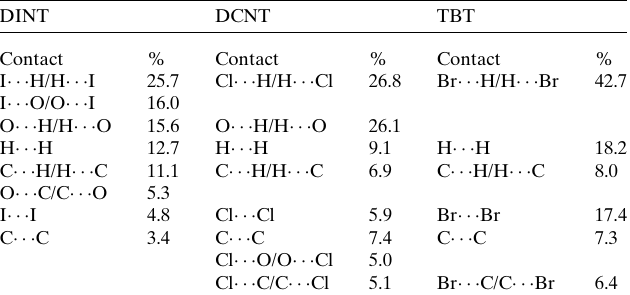
Table 1 Hydrogen bonds (A˚ , (cid:3) ) for (I) and (II). Compound